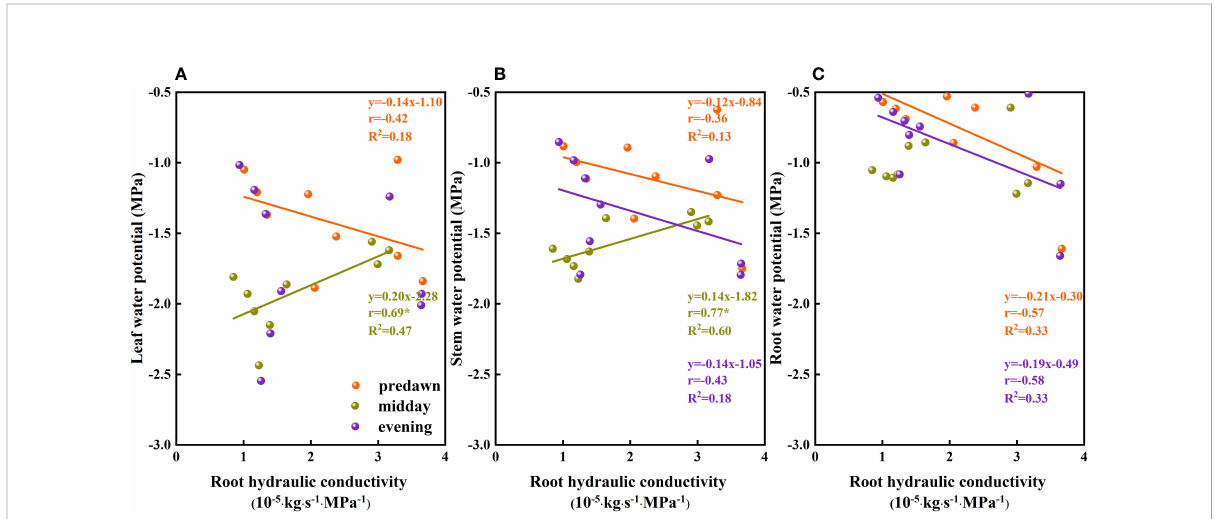
FIGURE 11 The relationship between the plant water potential and root hydraulic conductivity of Ferula bungeana . (A – C) present data for the relationships between leaf, stem, and root water potential and root hydraulic conductivity,